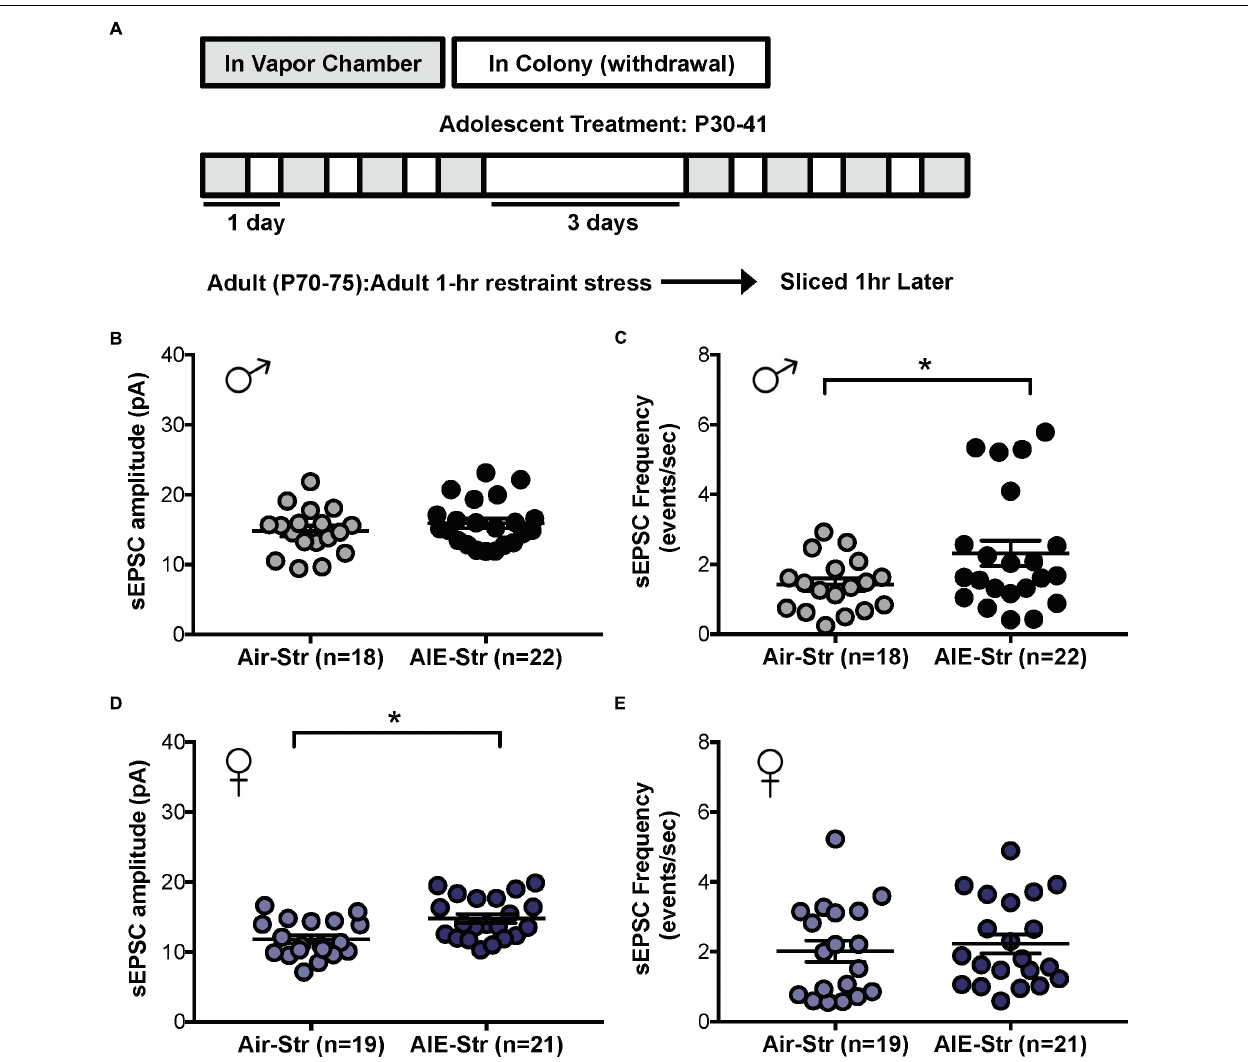
FIGURE 7 | Spontaneous EPSCs in adult male and female mice with a history of AIE following a restraint stress challenge. (A) Protocol used to evaluate whether acute restraint stress (1 h, Str) during protracted withdrawal would alter NMDARs in adults with a history of AIE (AIE-Str) relative to air controls (Air-Str). Slices were obtained from mice 1 h after termination of the restraint stress. Quantification of sEPSC frequency (C) and amplitude (B) in dlBNST neurons of AIE-Str and Air-Str male mice. Quantification of sEPSC frequency (E) and amplitude (D) in dlBNST neurons of AIE-Str and Air-Str male mice. Lines show mean ( ± SEM), symbols indicate significant differences determined by unpaired t -tests; ∗ p <